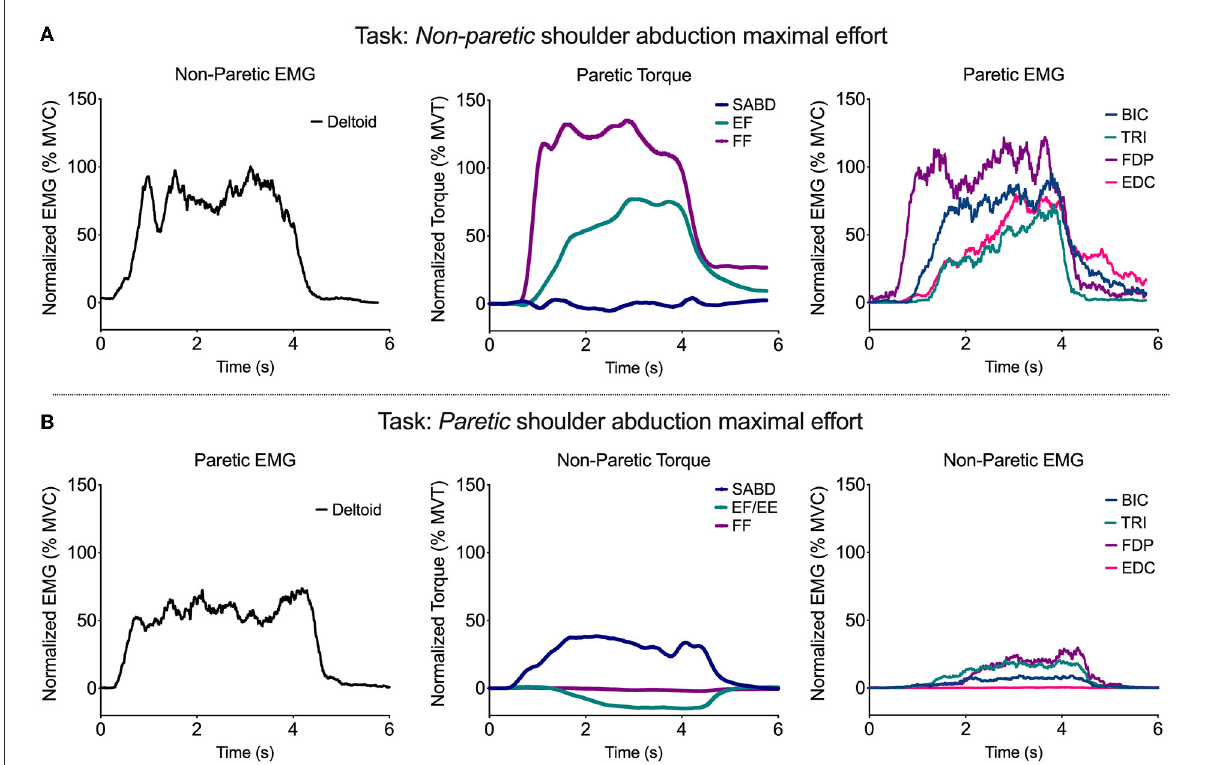
FIGURE6 Representative single-trial data from one participant during a shoulder abduction maximal effort performed by the non-paretic (A) and paretic (B) limbs. EMG from the deltoid of the limb performing the task is shown in the left plot, SABD, EF/E, and FF torque from the contralateral limb is shown in the middle plot, and BIC, TRI, FDP, and EDC EMG from the contralateral limb are shown in the right plot.